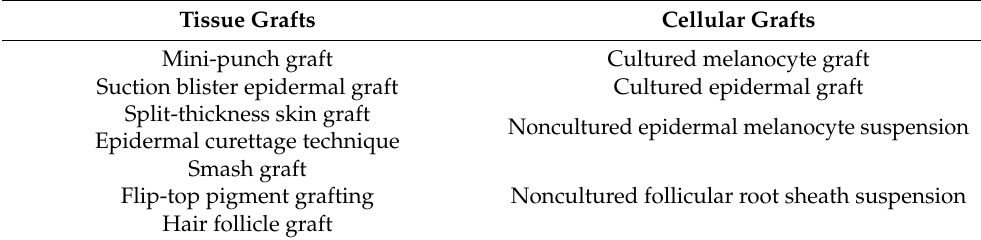
Table 1. Classification of surgical methods for the treatment of